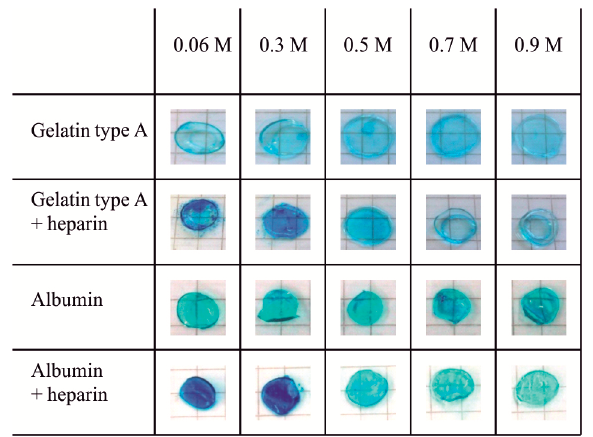
Figure 1. Critical electrolyte concentration (CEC) staining of gelatin type A (10 wt %) and albumin (10 wt %) hydrogels without heparin or with heparin (1 wt %) that were crosslinked with 1-ethyl-3-(3-dimethylaminopropyl) carbodiimide (EDC) (0.125 M). Hydrogels were washed for at least 5 h in PBS + before staining. Alcian blue solutions (0.05%, pH 5.8) with 0.06 to 0.9 M MgCl 2 were applied for staining. Hydrogels without heparin showed no dependence of staining on electrolyte concentration, indicating that the CEC for albumin and gelatin hydrogels was lower than 0.06 M MgCl 2 . For heparin-functionalized hydrogels, the CEC was 0.5 M MgCl 2 . The positively charged dye Alcian blue stains negatively charged functional groups e.g.,